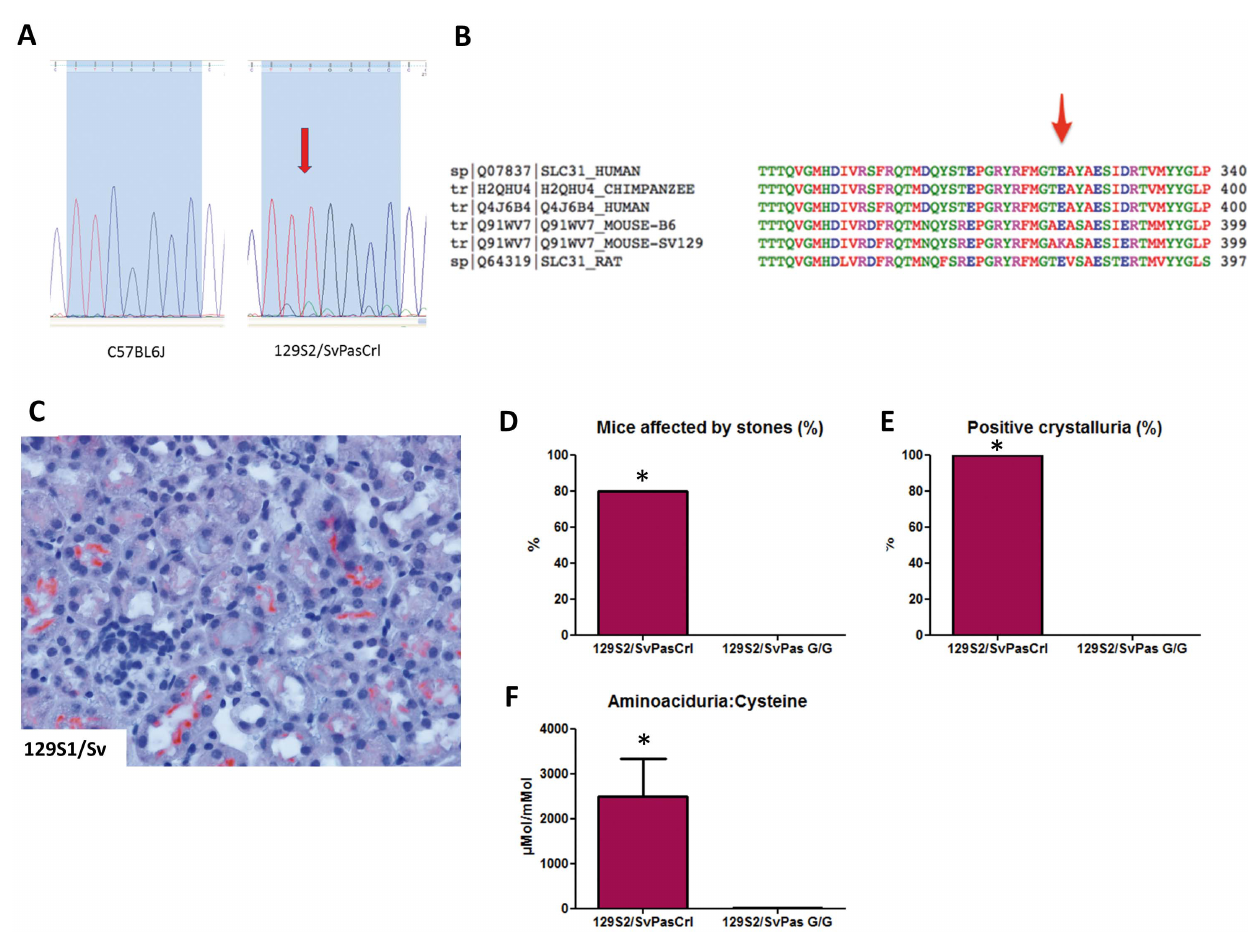
Figure 5. Identification of a functional missense mutation in a highly conserved sequence of the Slc3a1 gene in 129S2/SvPasCrl mouse. A , Mutation of G by A nucleotide at position 1232 in 129S2/SvPasCrl mouse (c.1232G . A). B , In position 383, the glutamine is substituted by a lysine in the extracellular part of rBAT protein in 129S2/SvPasCrl mouse. The sequence is highly conserved among mammal species. C , 129S1/Sv mice from the Jackson laboratory express rBAT at the brush border of proximal tubular cells. D , Eighty percent of 129S2/SvPasCrl mice sacrificed at 10 weeks were affected by urolithiasis whereas no 129S2/SvPas (G/G genotype) mouse was affected (n=5/group, p=0.047). E , One hundred percent of 129S2/SvPasCrl mice presented cystine crystals in urine whereas no 129S2/SvPas (G/G genotype) mouse was affected (n=5/group, p=0.008). F , Urinary aminoacid chromatography has been performed in 129S2/SvPasCrl mice and 129S2/SvPas mice (n=5/group). Cysteine (reduced form of cystine) was significantly higher in 129S2/SvPasCrl mice urine (p=0.008). Results are expressed as aminoacid concentration ( m Mol)/creatinine concentration (mMol) in urines.